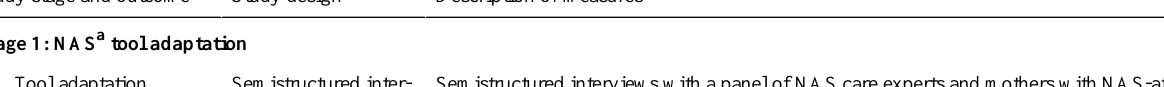
Description of measuresStudy designStudy stage and